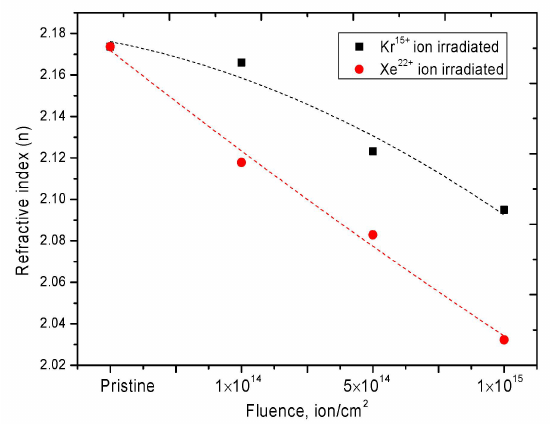
Figure 6. Graph of the refractive index changes depending on the radiation